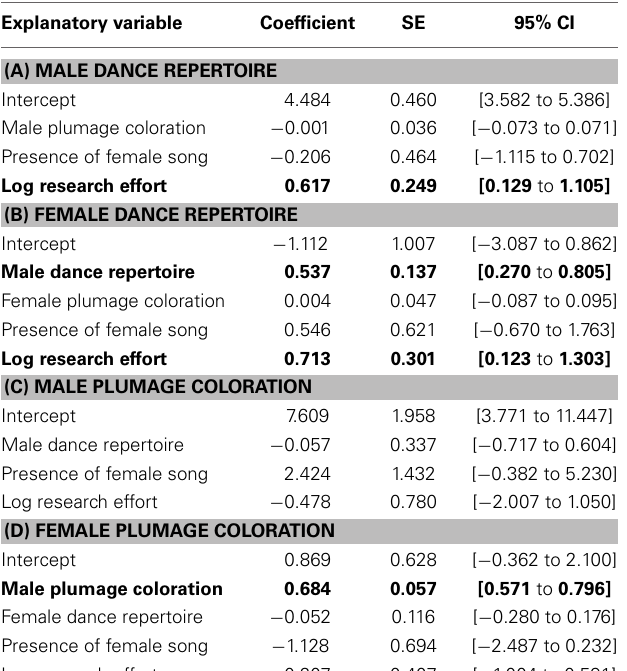
Table 1 | Associations among three sexual signals in Estrildid finches. Explanatory variable